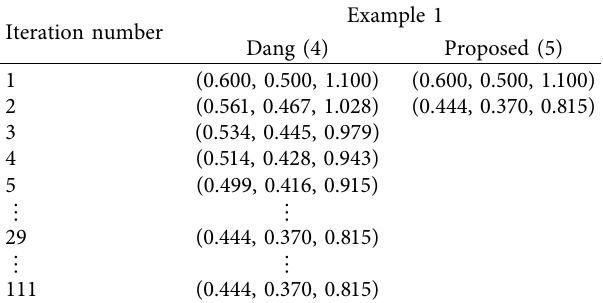
Table 2: Comparative sequences of the Dang method (4) and proposed method (5) for the numerical experiment of Example 1 with three decimal